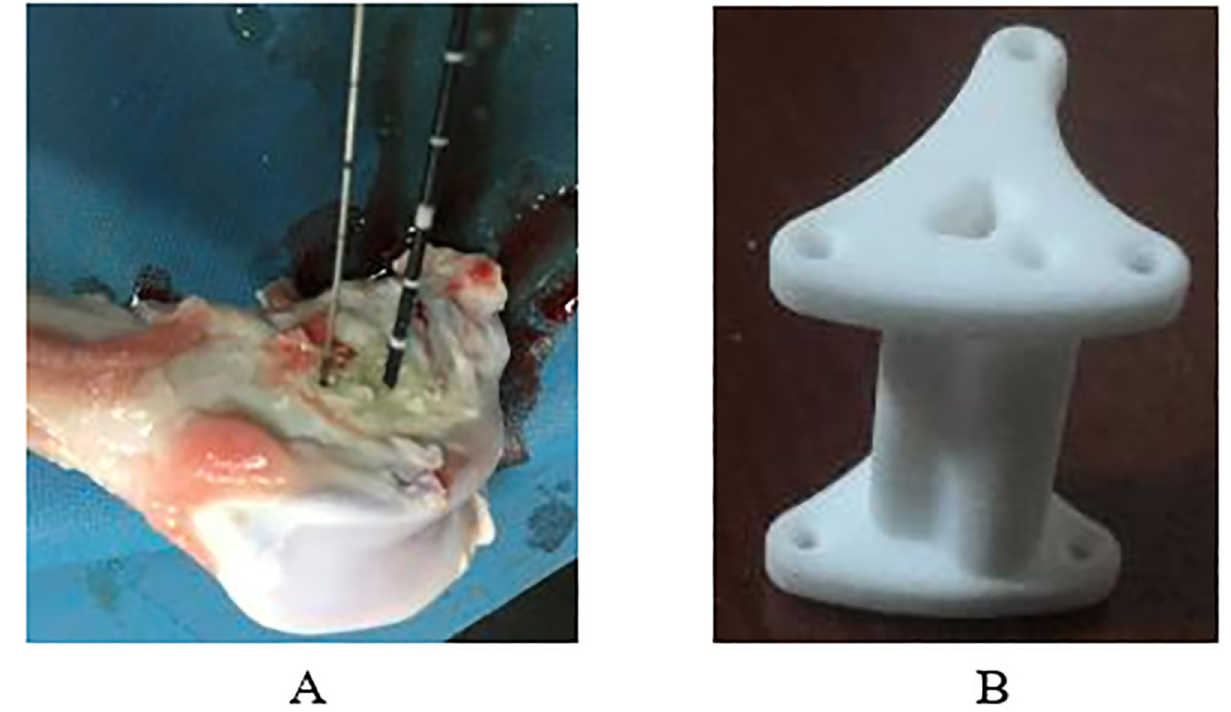
Fig 2. A. Ablation in a sheep femur metaphysis with temperature probe at 10mm. B. The 3D-printed navigation